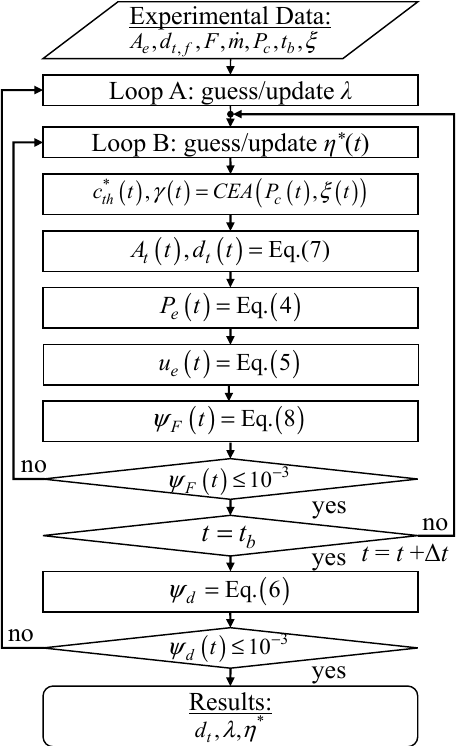
Figure 4. The NTRT + algorithm computational Figure 4. The NTRT+ algorithm computational flowchart. 235